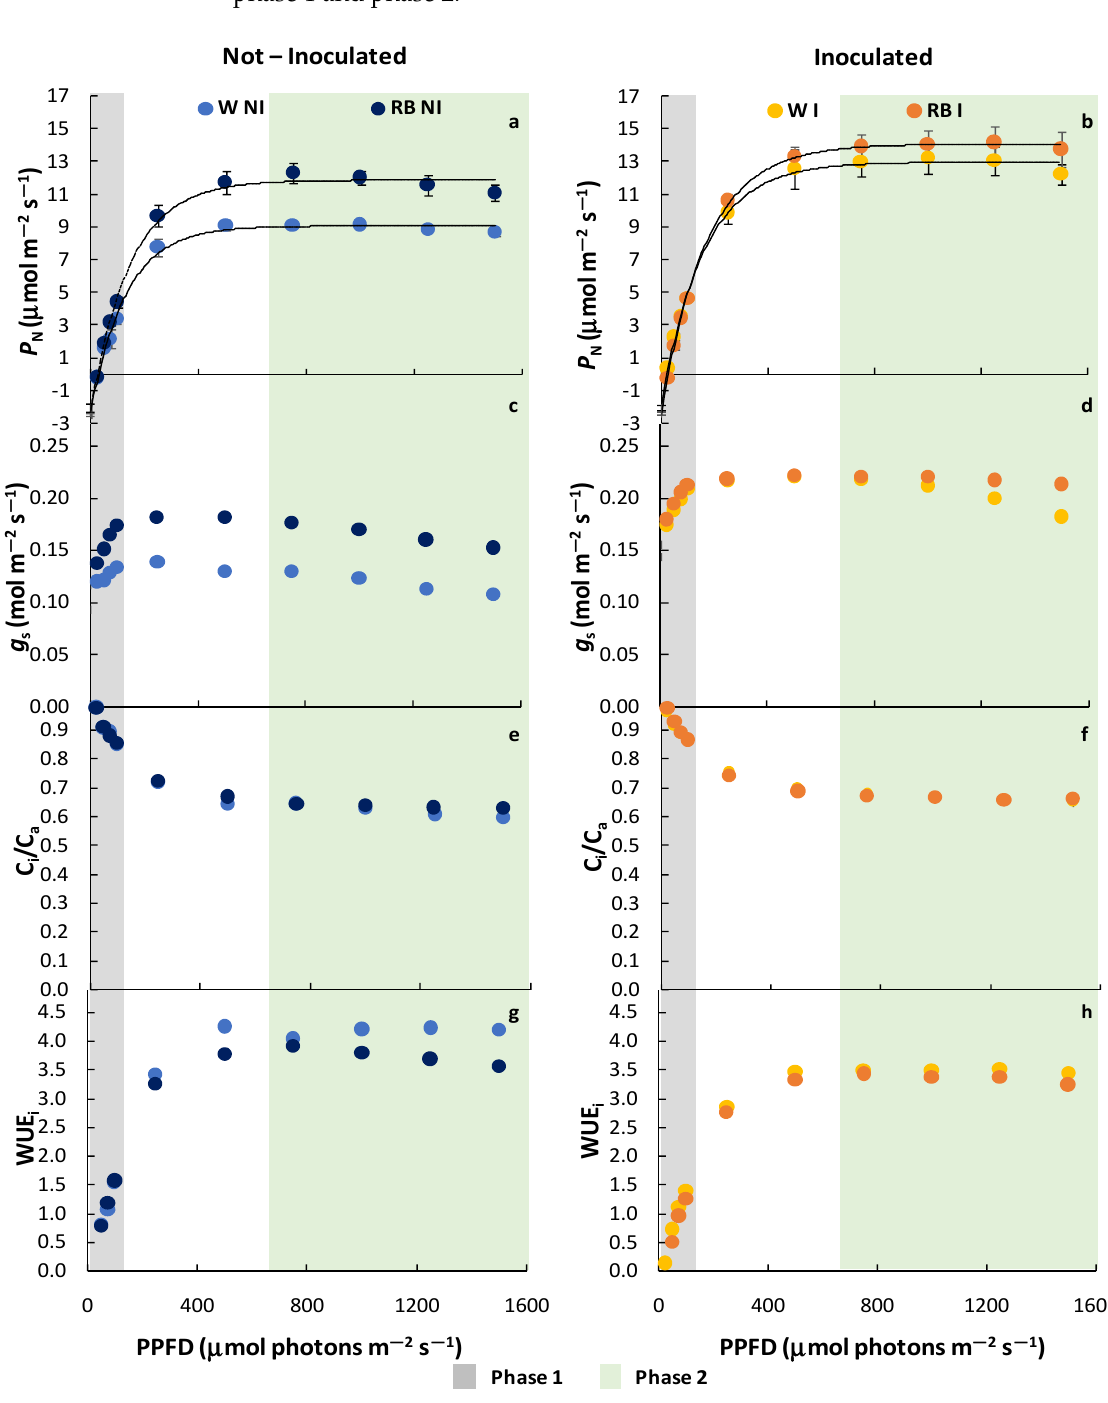
Figure 2. Net photosynthesis, P N(LRC) ( a , b ); stomatal conductance, g s ( c , d ); internal to atmospheric CO 2 concentration ratio ( C i / C a ) ( e , f ); instantaneous water use efficiency, WUE i ( g , h ) of not-inoculated (NI) and inoculated (I) spinach plants grown under W and RB light regimes. Data are means ± standard error (n = 5). phase 1 (grey) and phase 2 (green). LQ, PGPM, and their interaction did not affect Φ PSII and Φ NPQ on the entire curve. However, a significant effect was induced by the interaction of LQ × PGPM in phase 1. Only PGPM, as a single factor, significantly influenced Φ PSII and Φ NPQ in phase 2 (Table 2). In particular, I showed higher Φ PSII and lower Φ NPQ values than NI plants, regardless of LQ regime ( p < 0.05). Moreover, RB-NI plants were characterized by higher ( p < 0.001) Φ PSII compared to W-NI ones, while no difference occurred between W-I and RB-I plants